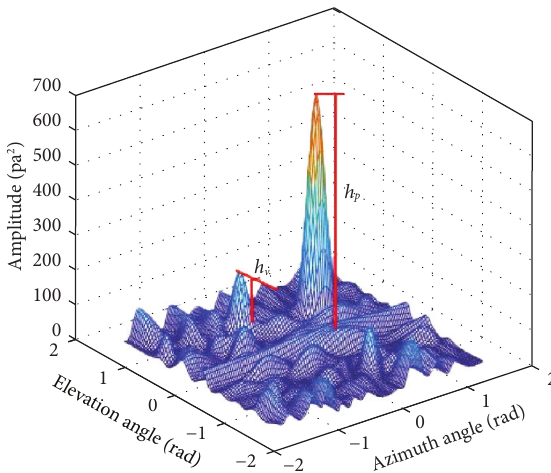
Figure 4: Three dimensional array pattern